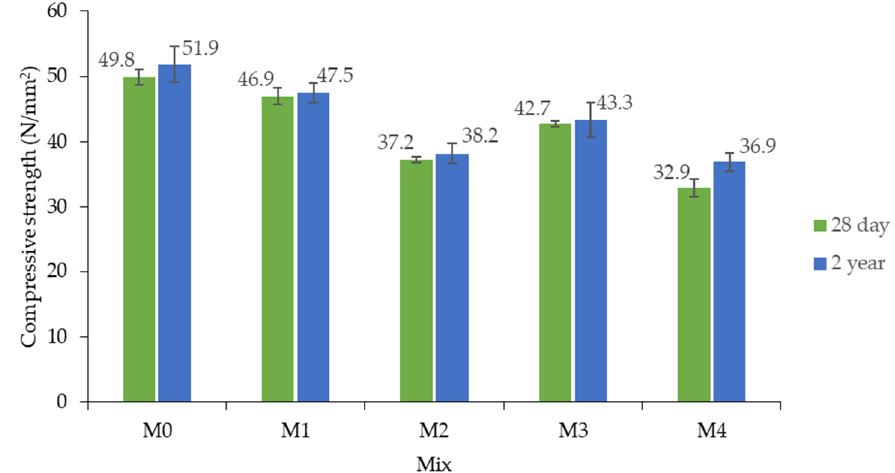
Figure 5. Compressive strength of concrete after 28 days and after 2 years.